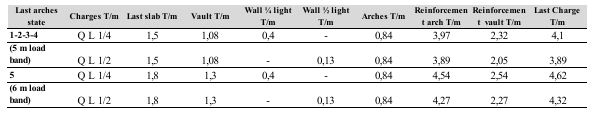
Table 2. Loads of the structural system: last state